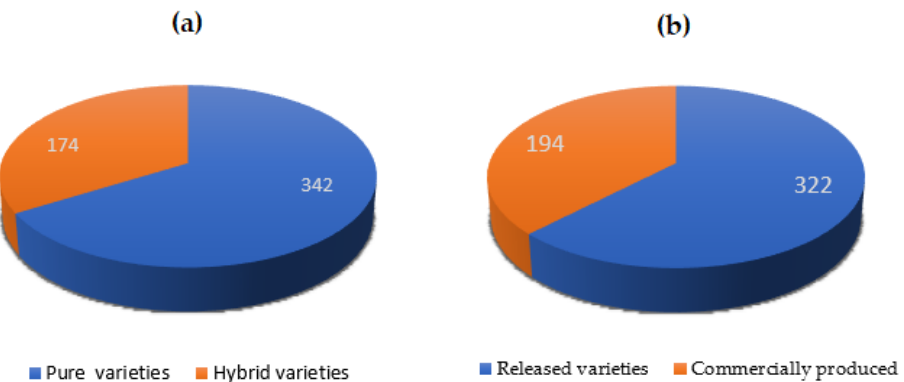
Figure 3. Number of released rice varieties in Vietnam up to October 2013. ( a ) Number of pure rice and hybrid varieties and ( b ) number of commercial rice varieties.